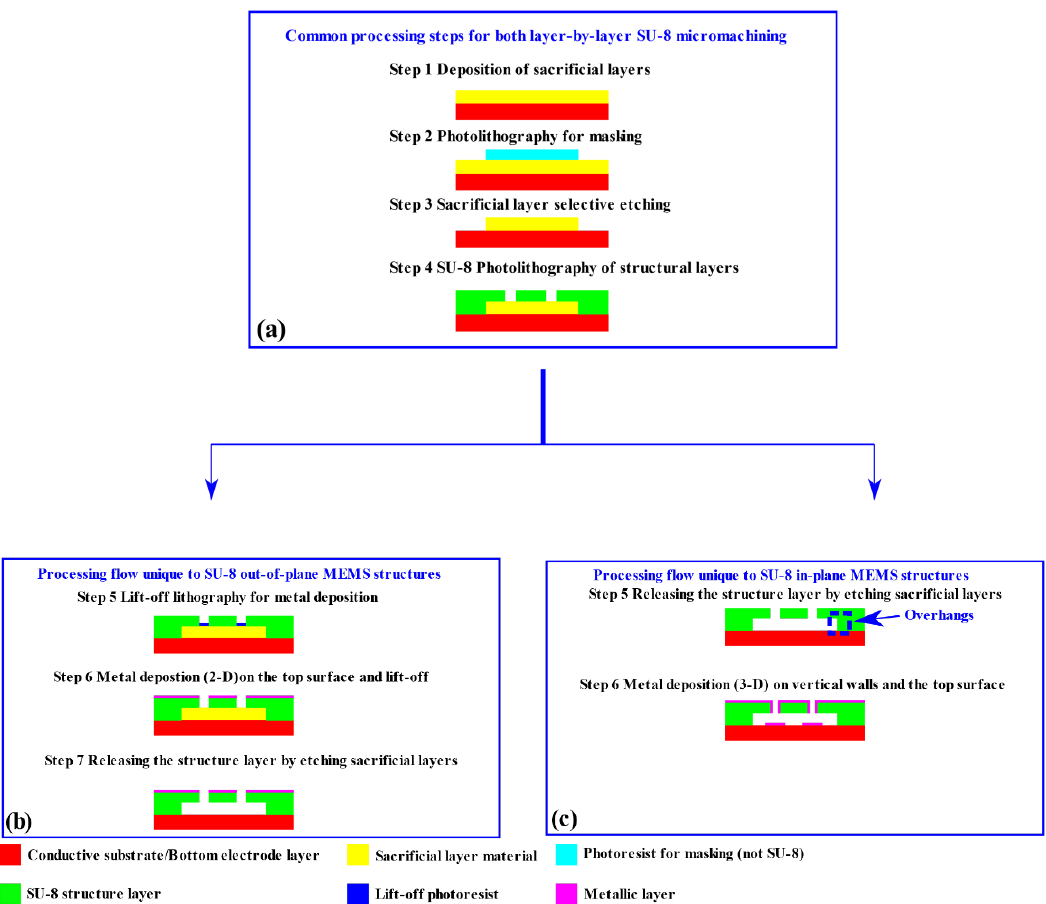
Figure 1. The generic schematics of layer-by-layer SU-8 micromachining. ( a ) Common steps; ( b ) Steps for out-of-plane SU-8 MEMS structures; ( c ) Steps for in-plane SU-8 MEMS structures.